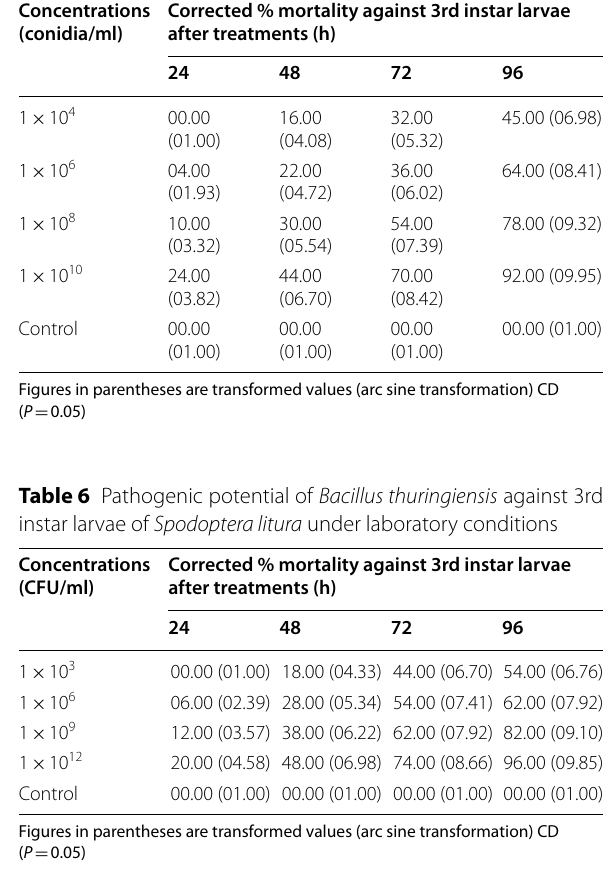
Figures in parentheses are transformed values (arc sine transformation) CD ( P 0.05) = Table 5 Pathogenic potential of Beauveria bassiana against 3rd instar larvae of Spodoptera litura under laboratory conditions